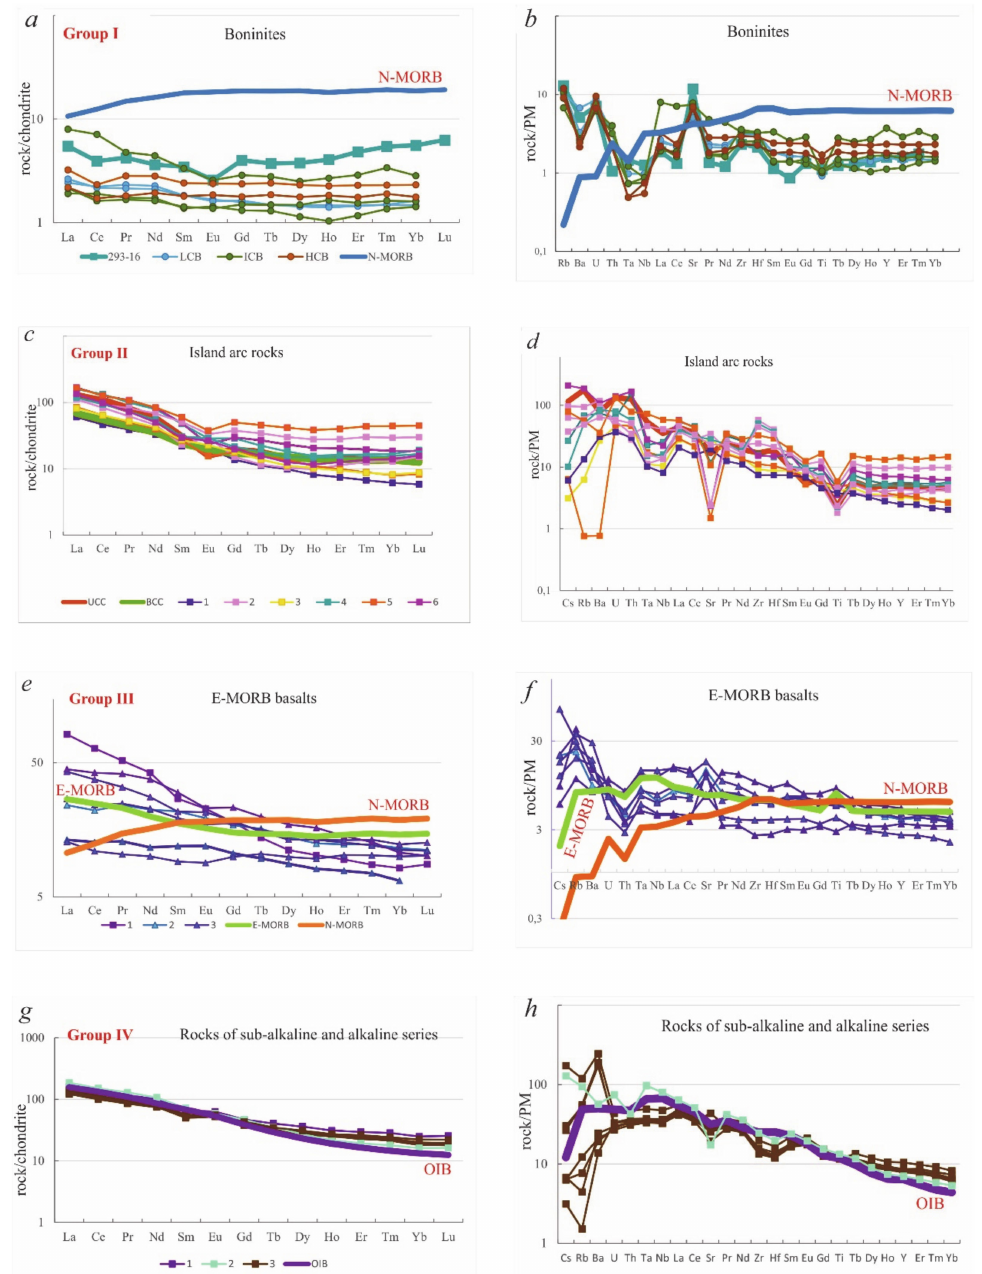
Figure 14. C1 chondrite normalized REE (rare earth elements) patterns and primitive mantle normalized trace element spidergram; normalizing values are from [65]: ( a , b ) Group I—boninites (293-16), literature data [60]: Low calcium (LCB), medium calcium (ICB), high calcium (HCB) boninites; ( c , d